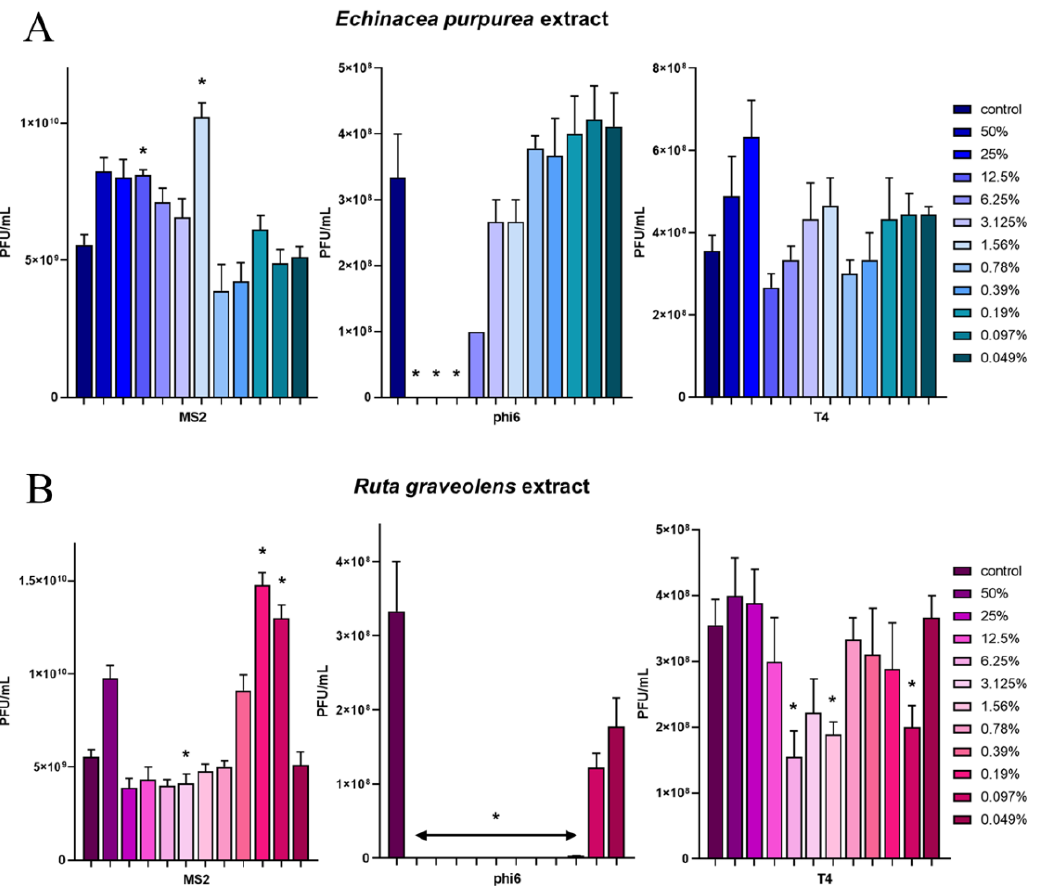
Figure 3. Phage titres (MS2, phi6 and T4) after 24 h exposure to different concentrations of plant extracts: results after coincubation of phages with Echinacea purpurea extract, ( A ) and after coincubation of phages with Ruta graveolens extract ( B ). Error bars represent standard deviation between the samples. The means sharing the star asterisk are significantly different from the control at p ≤ 0.05.